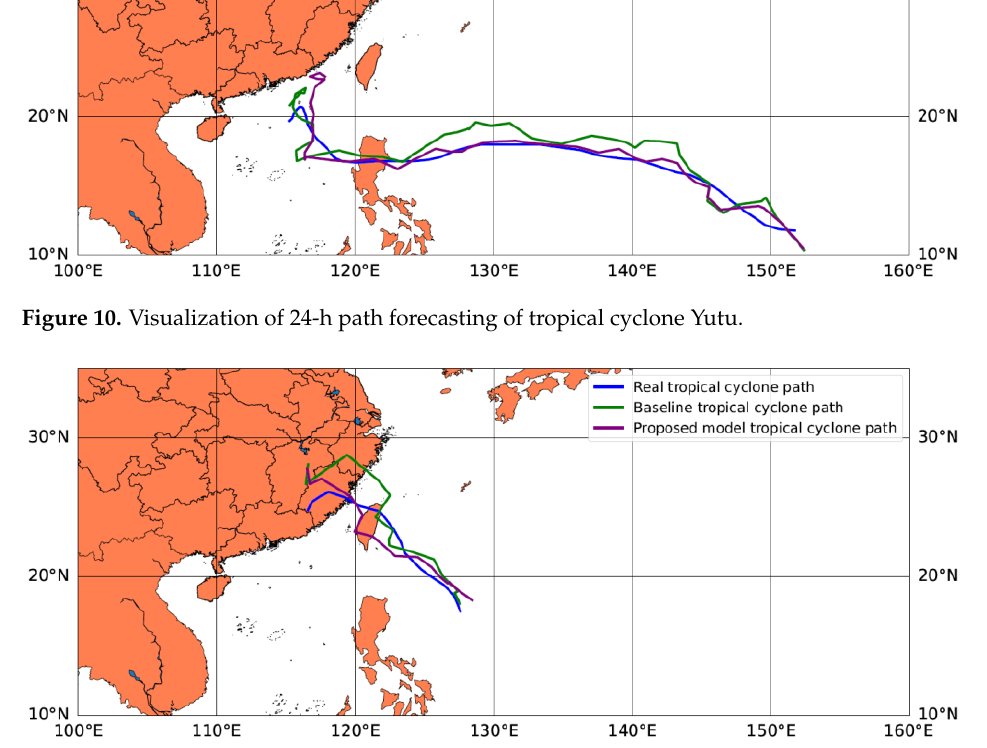
Figure 11. Visualization of 24-h path forecasting of tropical cyclone Nasha.